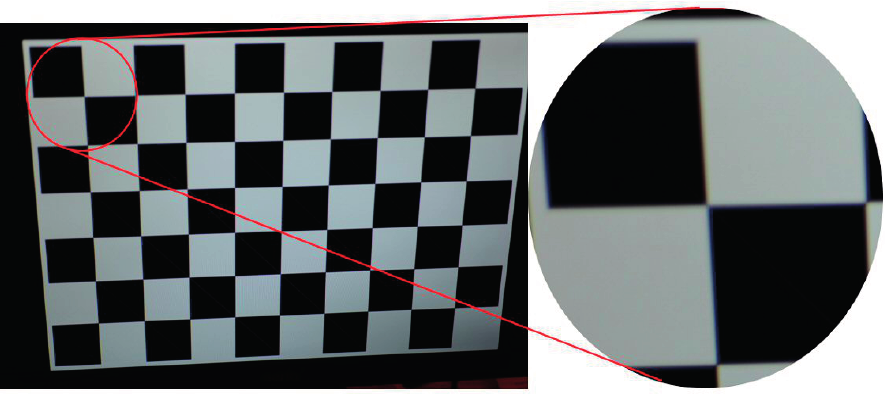
Figure 4. The upper left part of the image is appearing defocused. The software was unable to identify the intersection of the squares and perform the